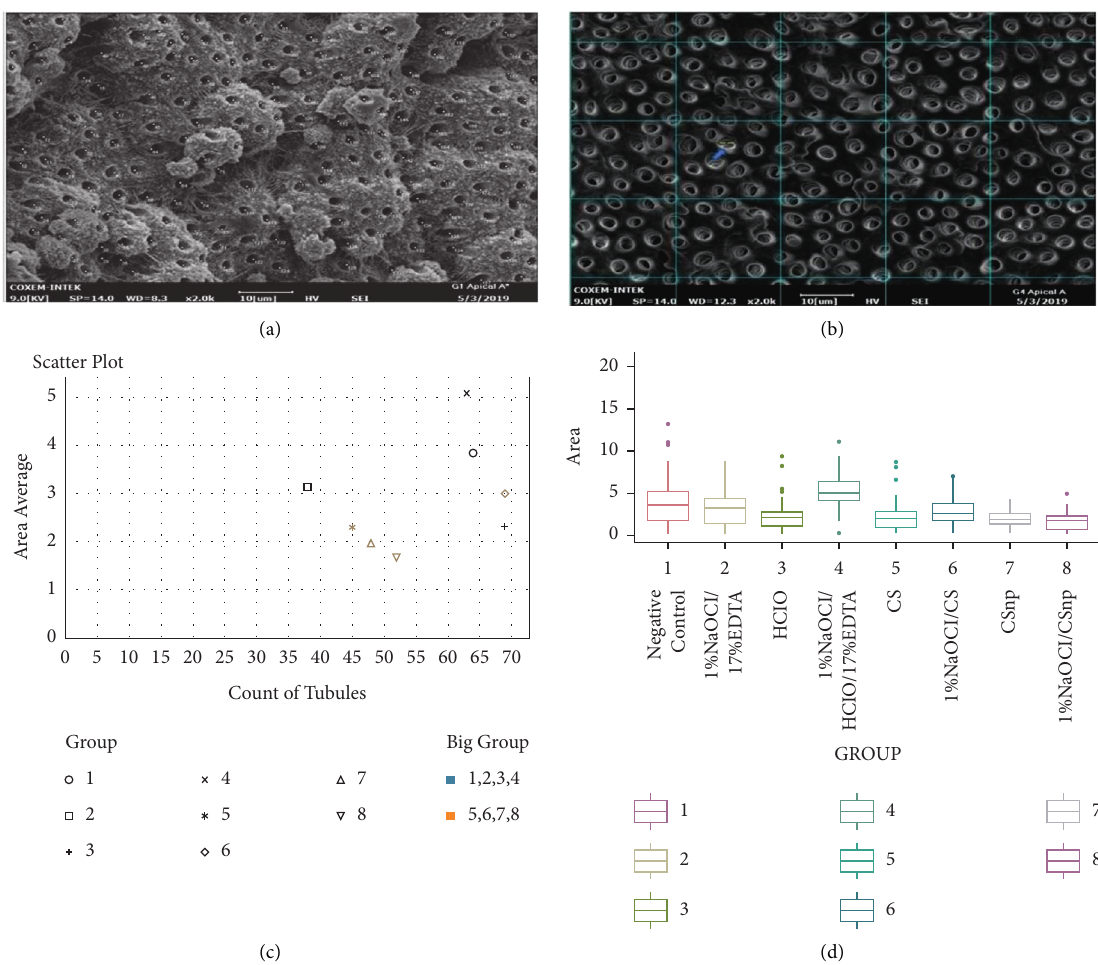
Figure 4: Computational routines for quantitative randomized analysis by SEM x2000. (a) Count of tubules per field. (b) Working field 20 × 20 µ m areas; the blue arrow shows the measurement of the tubular diameter. (c) Scatter diagram: area and tubule count per area. (d) Box plot: mean area per